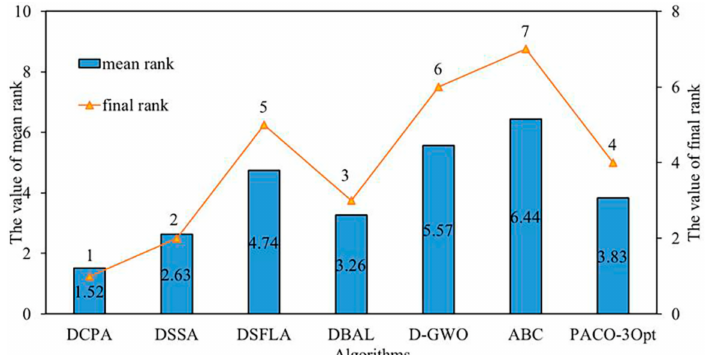
Figure 6. The ranks of the seven participating algorithms.